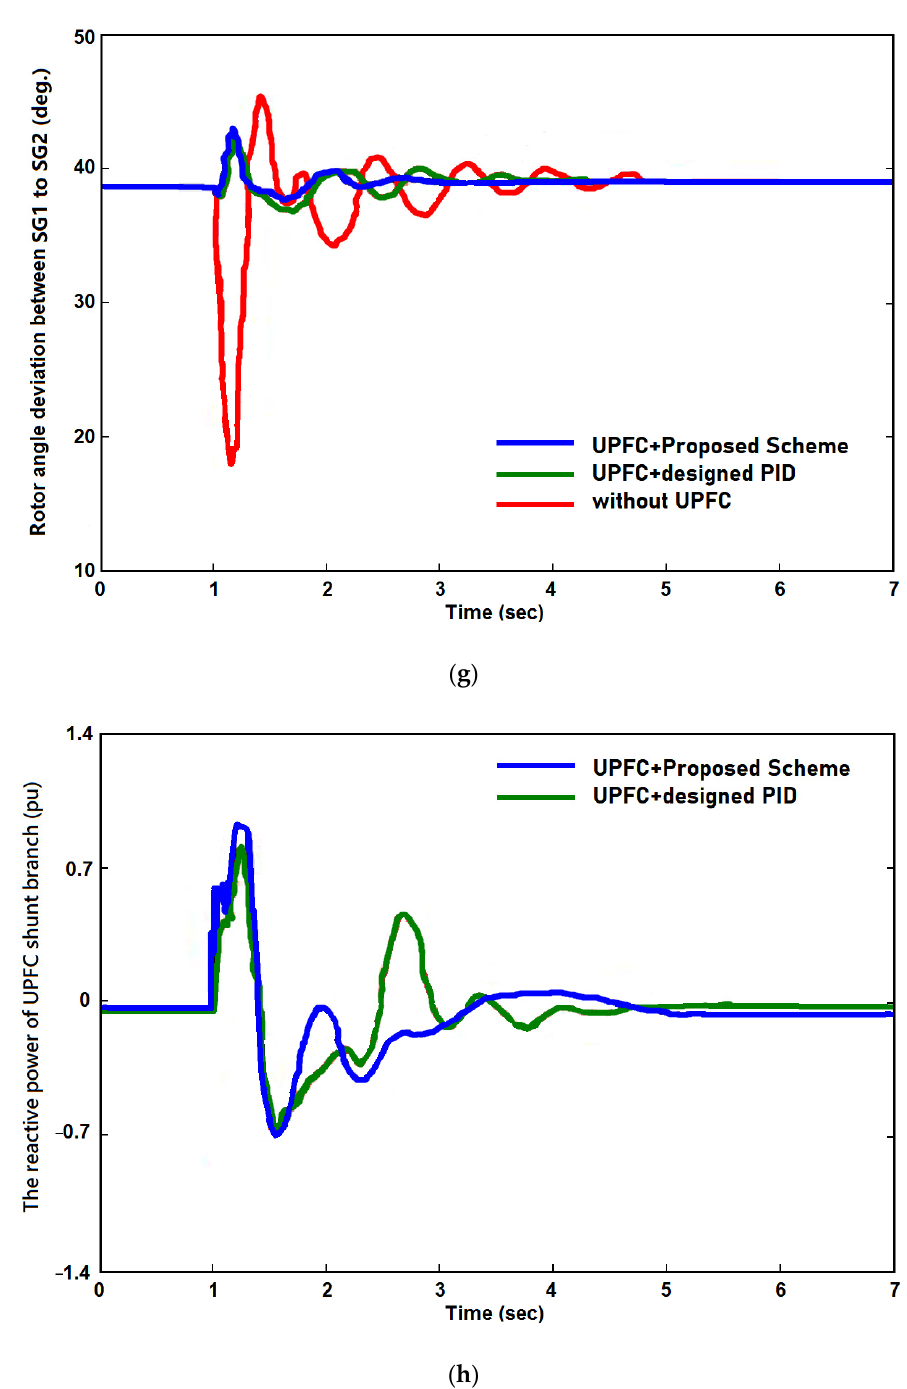
Figure 7. Transient responses of the proposed system for three phase short circuit fault for 0.1 s at the grid: ( a ) Active power response of Line 1, ( b ) Active power response of Line 2, ( c ) Voltage of Bus 4, ( d ) Terminal voltage of SG1, ( e ) Rotor speed of SG1, ( f ) Rotor speed of SG2, ( g ) Rotor angle deviation between SG1 to SG2, ( h ) Reactive power response of UPFC.